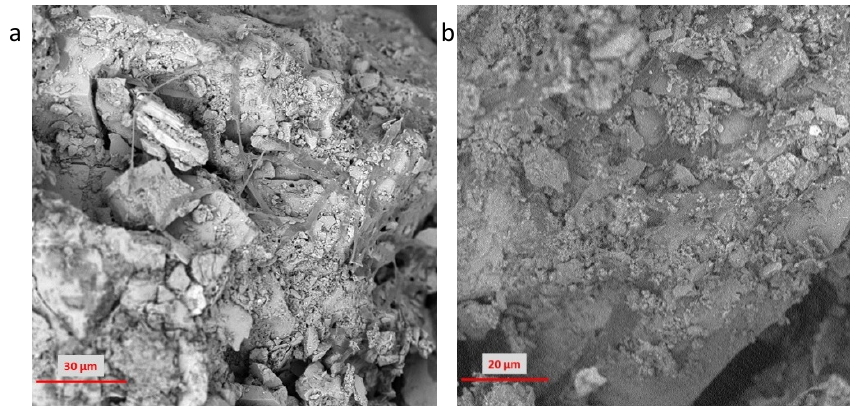
Figure 5. Scanning Electron Micrographs of growth within biosandstones. (a) P. crysogenum MUM 974 with magnification of 2000x and (b) N. crassa MUM 9208 with magnification of